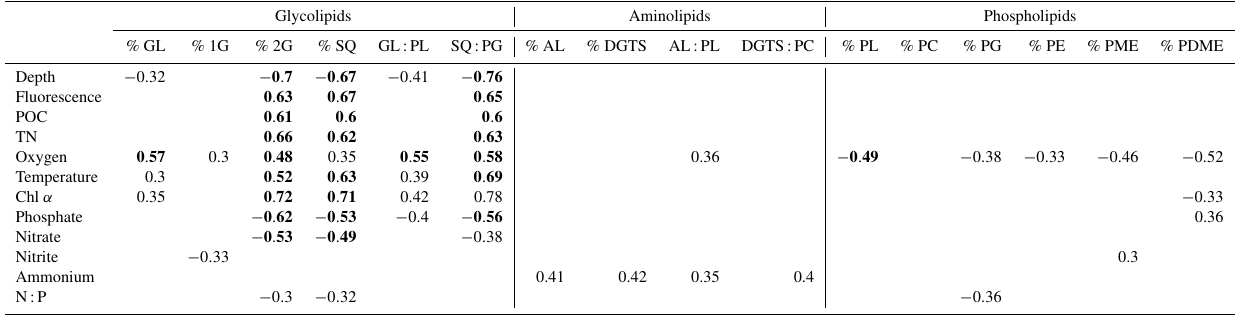
Table 1. Spearman’s rank order correlation coefficients ( r ) for data combined from all four stations. Only significant correlations where p< 0 . 05 (highly significant p< 0 . 001 in bold) are